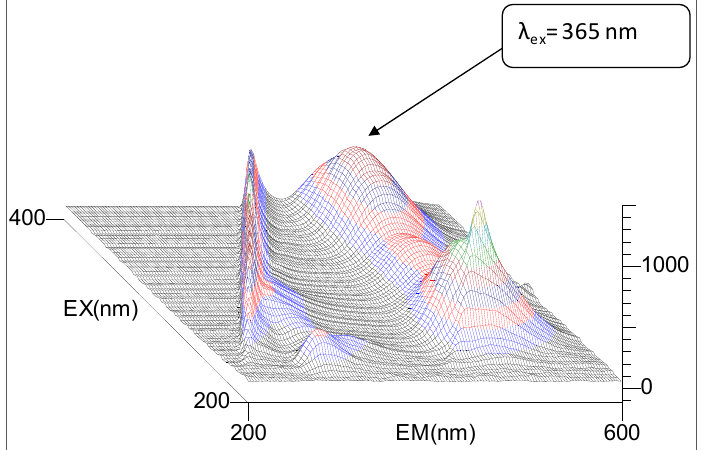
Figure 5. Three-dimensional spectrum of 3-aminoflavone in methanol. Intensity of fluorescence emission I f in RFU (relative fluorescence unit). Instrument parameters. Measurement type: 3D scan; data mode: Fluorescence; EX (Excitation) sampling interval: 3.0 nm; EM (Emission) sampling interval: 3.0 nm; scan speed: 1200 nm/min; EX slit: 5.0 nm; EM slit: 5.0 nm; PMT (Photomultiplier Tube) voltage: 700 V; sensitivity: 1; threshold: 1.0.